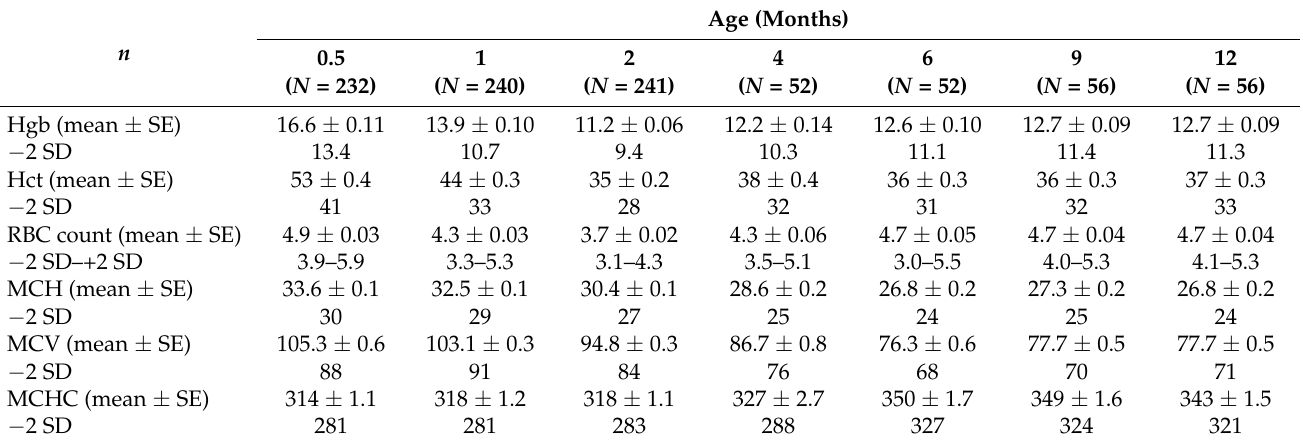
Table 2. Normal values of hemoglobin (Hgb g/dL), hematocrit (Hct%), Red blood cell count